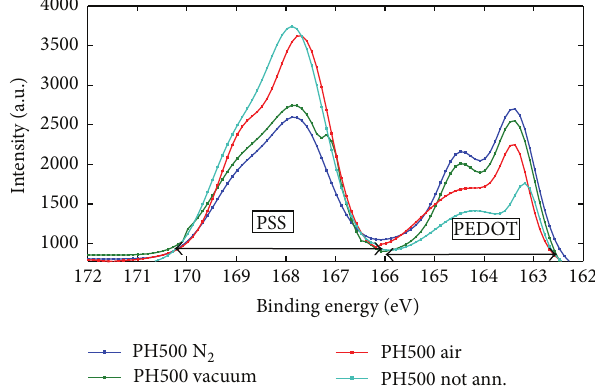
Figure 2: S 2p XPS peaks of PH500 samples annealed in air, N 2 , and vacuum at 220 ∘ C and also PH500 which is not